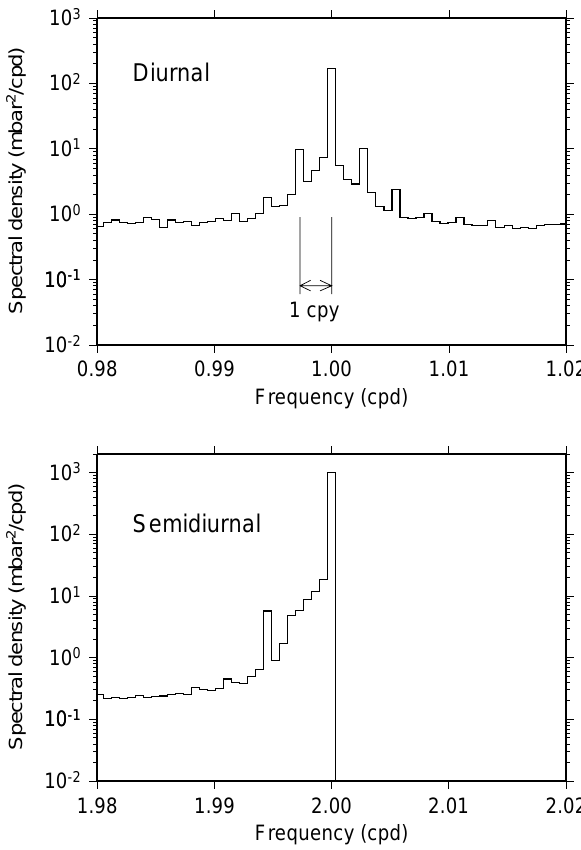
Fig. 14. Detailed views of the spectrum of Fig. 13 surrounding the diurnal and semidiurnal peaks. Frequency resolution is